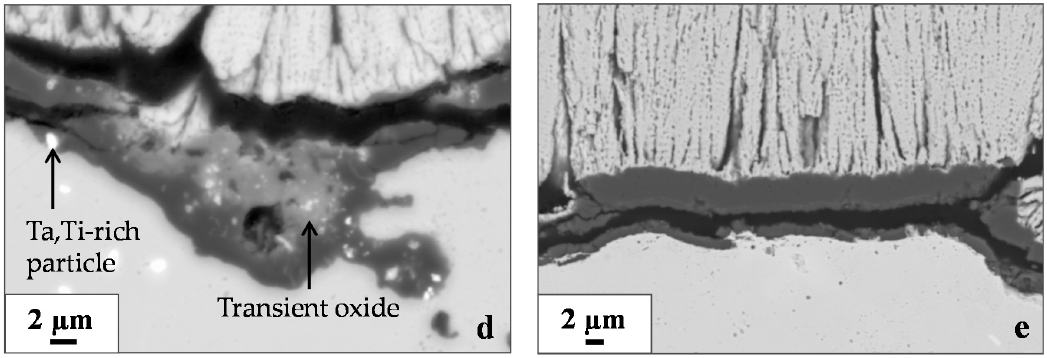
Figure 3. Cross-sections of ( a , c , e ) AM3-Trib-Pt/1 TBC system after 290 cycles; and ( b , d ) AM3-Trib TBC system after 36 cycles. Thermal cycles of 1 h at 1100 °C, with a high flow air cooling. ( a ) Presence of many corn kernel defects due to a rough bond-coating surface before thermal barrier deposition; ( b ) Cracking at thermally grown oxide (TGO)/thermal barrier interface; ( c ) Thermal barrier still adherent to the TGO, except at corn kernel areas; ( d ) TGO not only composed of alumina; ( e ) Only alumina detected in the TGO. SEM images in BSE mode.